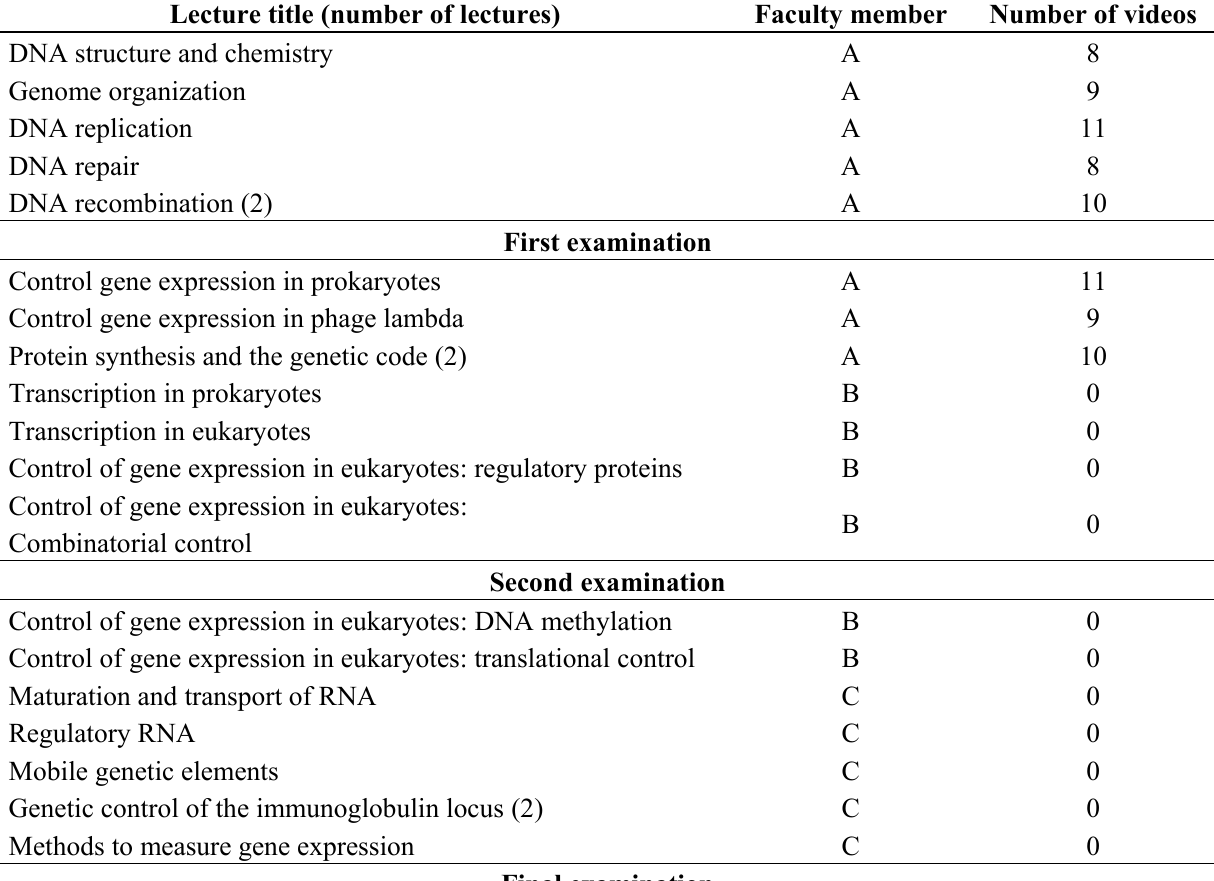
Figure 1. Daily numbers of views of the videos during the complete academic term. Table 1. Structure of the molecular biology